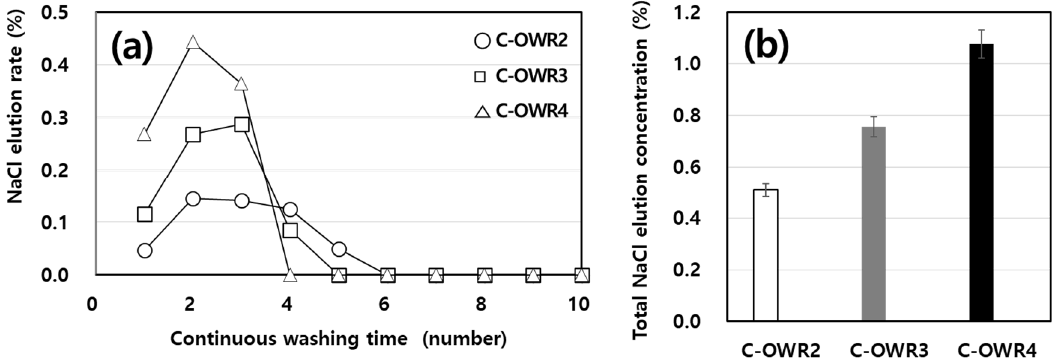
Figure 5. Amount of NaCl elution with continuous washing steps at different OWRs. ( a ) Changes in NaCl concentration as a function of washing steps. ( b ) Total NaCl elution concentration after 10 times of sequential washing.